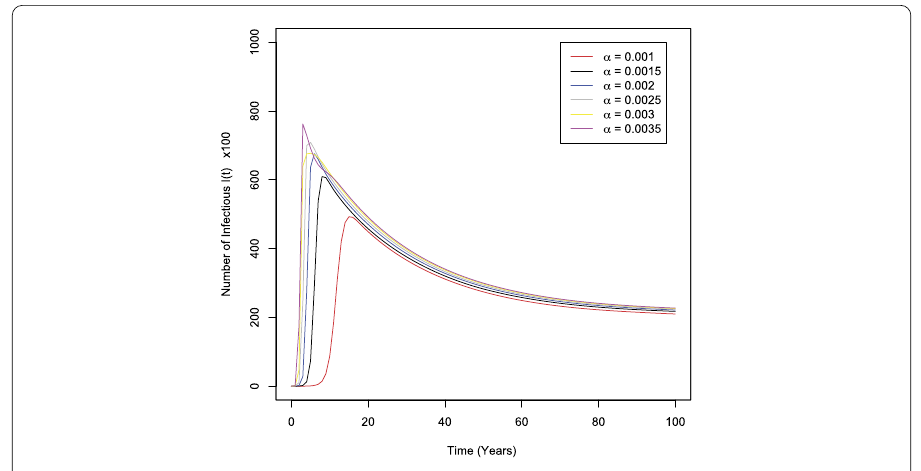
Figure 5 Evolution of the model by maintaining the transmission rate of TB λ = 0.100, we show the result of simulation when α = 0.0010,0.0015,0.0020,0.0025,0.0030 and